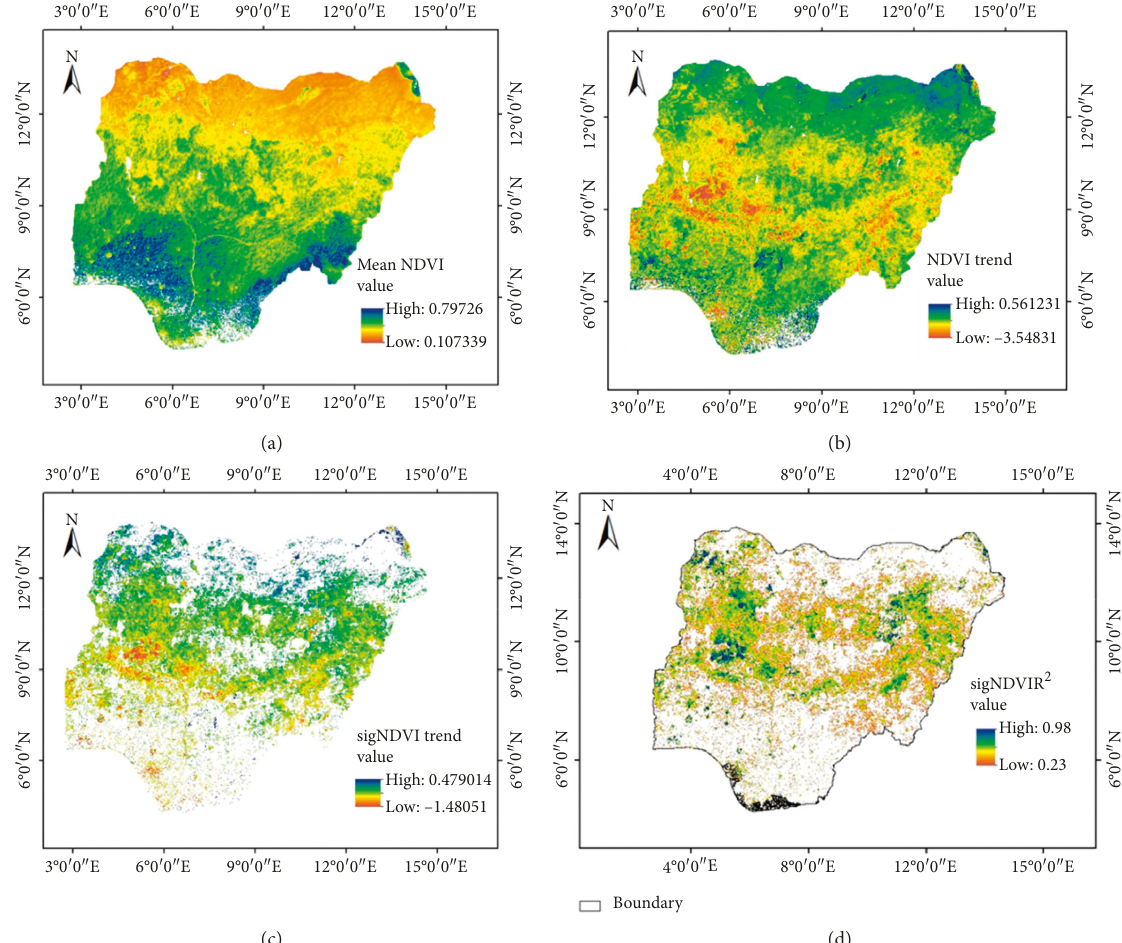
Figure 2: Pattern of NDVI in the study area from 2001 to 2017: (a) mean annual NDVI; (b) mean NDVI trends; (c) significant NDVI trends; (d) significant NDVI coefficient of determination ( R 2